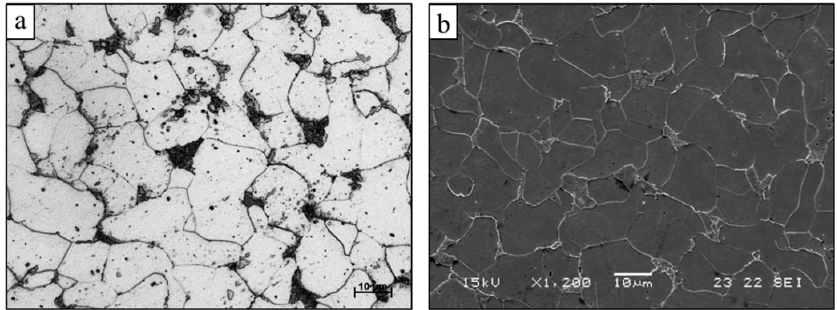
Figure 2. Typical microstructure of the counterpart ST-37 alloy: ( a ) optical microscopy; ( b ) scanning electron microscopy.